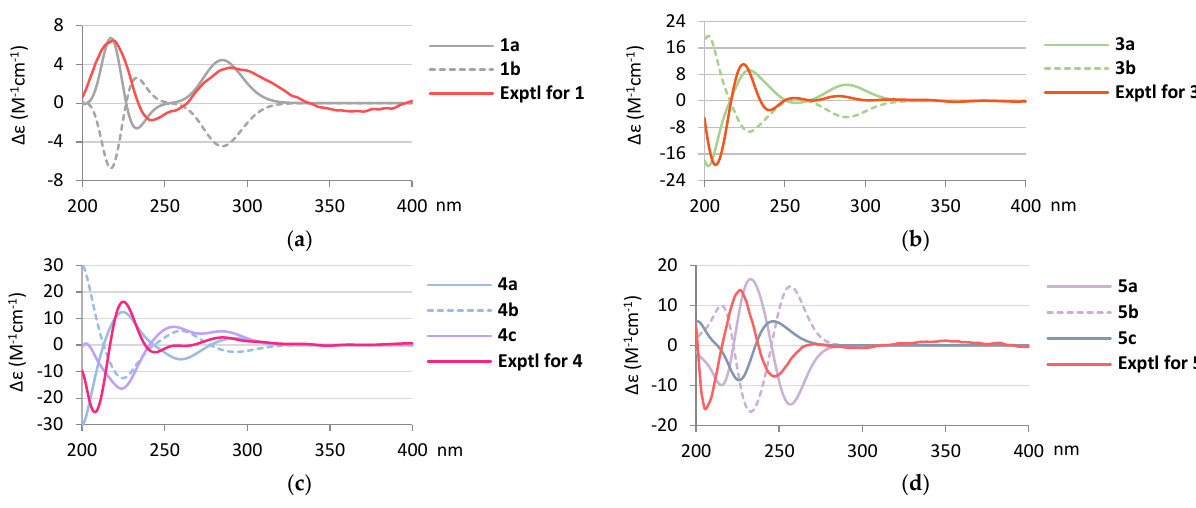
Figure 4. ( a ) Calculated ECD curves of 5 R ,8 R ,9 R ,10 R - 1 ( 1a ), 5 S ,8 S ,9 S ,10 S - 1 ( 1b ) and the experimental CD curve of 1 . ( b ) Calculated ECD curves of 5 R ,8 R ,9 R ,10 R - 3 ( 3a ), 5 S ,8 S ,9 S ,10 S - 3 ( 3b ) and the experimental CD curve of 3 . ( c ) Calculated ECD curves of 5 R ,8 R ,9 R ,10 R ,16 R - 4 ( 4a ), 5 S ,8 S ,9 S ,10 S ,16 S - 4 ( 4b ), 5 R ,8 R ,9 R ,10 R ,16 S - 4 ( 4c ) and the experimental CD curve of 4 . ( d ) Calculated ECD curves of 3 R ,5 R ,8 R ,9 R ,10 R ,15 R - 5 ( 5a ), 3 S ,5 S ,8 S ,9 S ,10 S ,15 S - 5 ( 5b ), 3 R ,5 R ,8 R ,9 R ,10 R ,15 S - 5 ( 5c ) and the experimental CD curve of 5 .